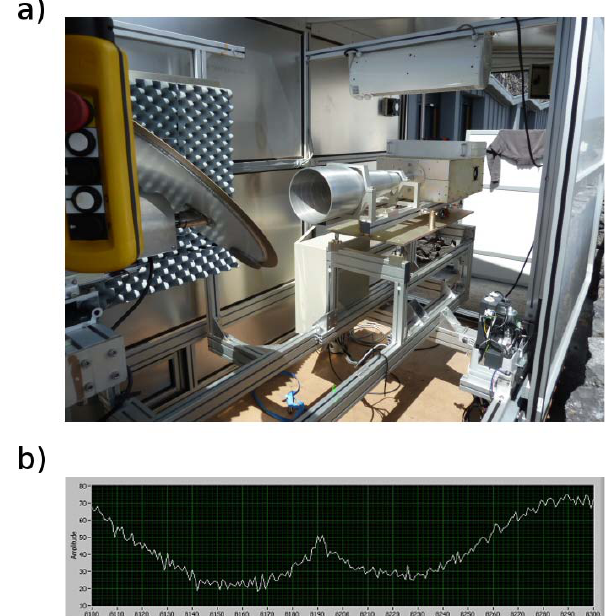
Fig. 7. (a) Photo showing the DODO radiometer installed at the Maïdo Observatory in March 2013. (b) Calibrated spectra (Kelvin) obtained on 12 April 2013 at the Maïdo station facility after an in- tegration time of 20h focusing on the center of the spectrometer (H 2 O line center is located at the channel number